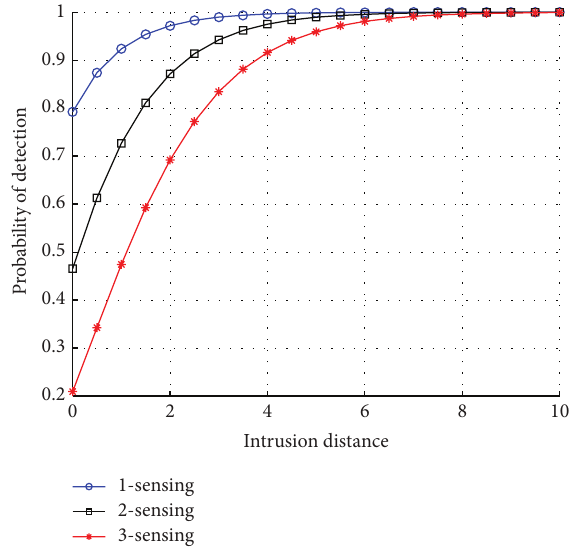
Figure 6: Single-sensing detection probability versus multi-sensing detection